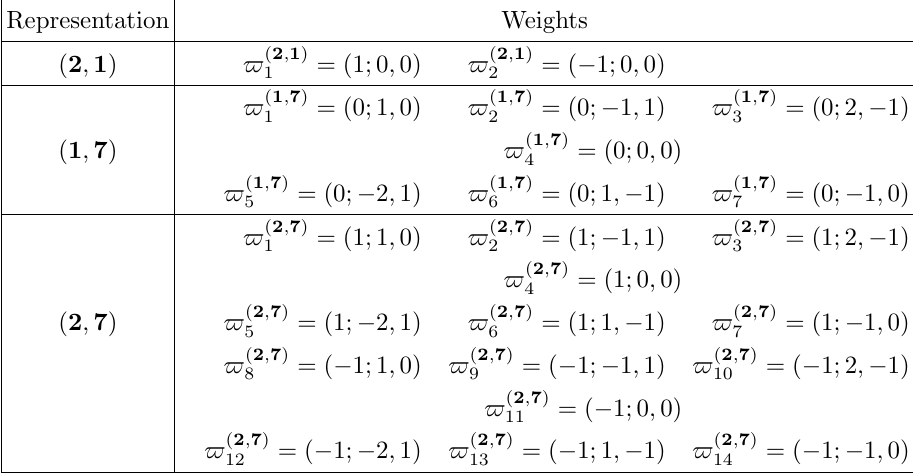
Table 2 . Weights of the representations of A